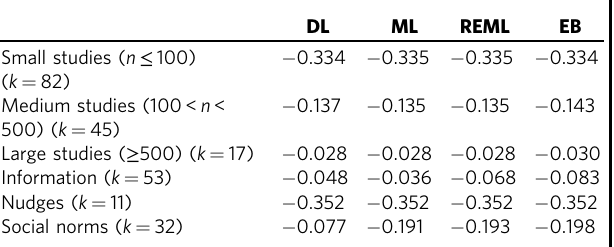
Table 2 Sensitivity analyses per moderator with different estimators (Cohen ’ s d